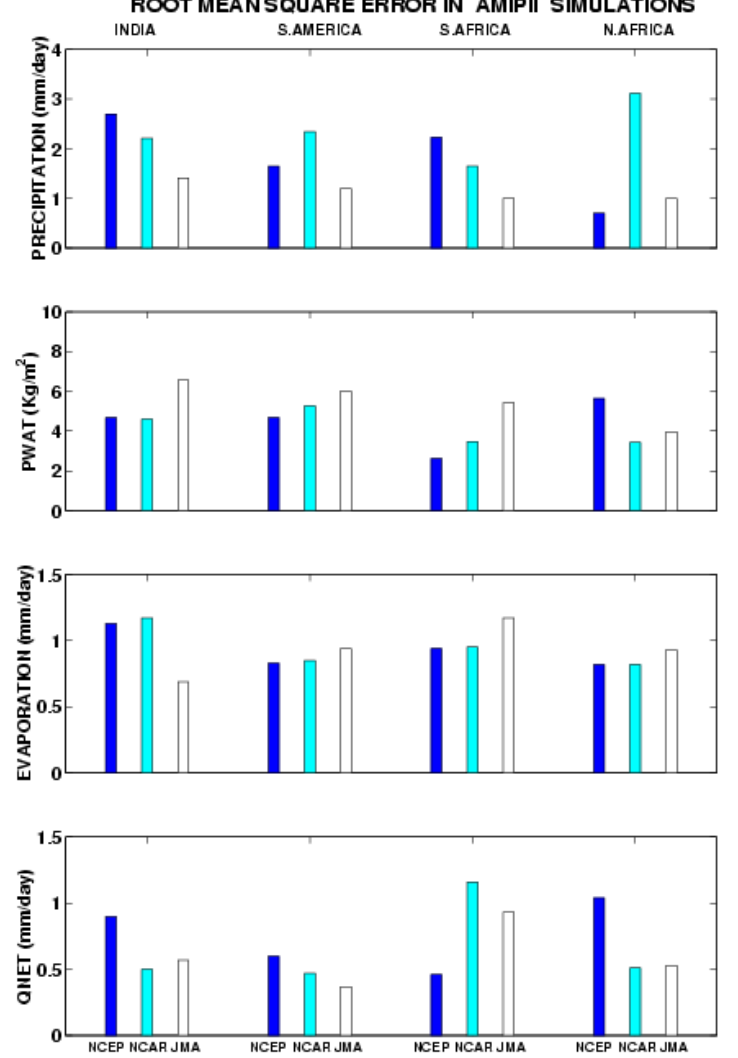
Fig. 3. Root mean-square error in rainfall, integrated water vapour, net radiation, and evaporation in NCEP, NCAR and JMA GCM in different continental